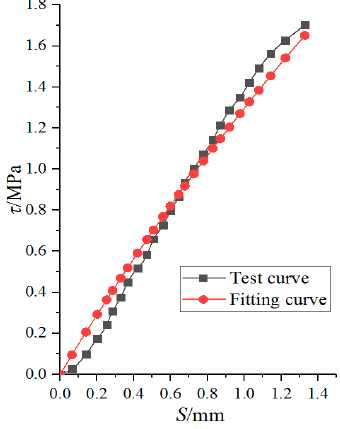
Figure 13. Comparison fitting curve with test curve.